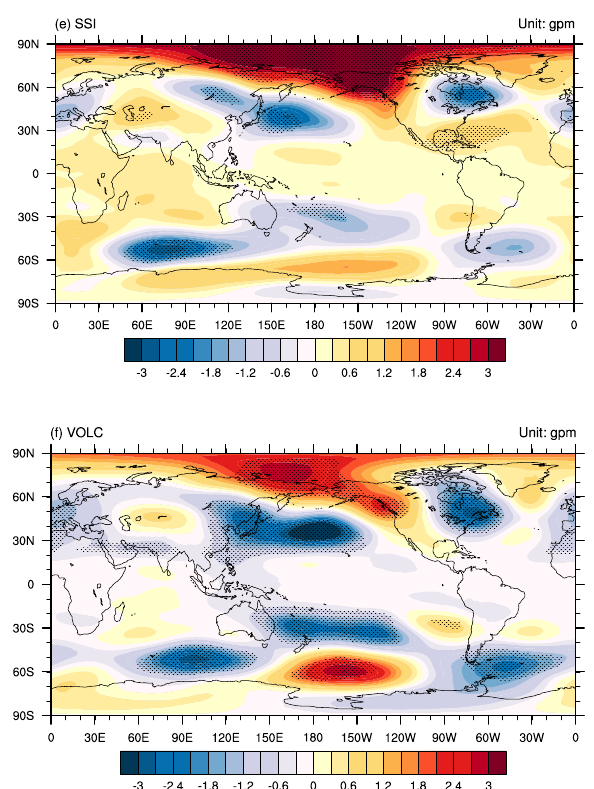
Figure 6. Simulated ensemble-averaged annual geopotential height anomalies at 500 hPa (unit: gpm) during the megadrought years from the long-term means of the control (CTRL) run ( a ), all-forcing (ALL) runs ( b ), greenhouse gas (GHG) runs ( c ), land use and land cover (LULC) runs ( d ), spectral solar irradiance (SSI) runs ( e ), and volcanic eruption (VOLC) runs ( f ). Stippling indicates differences significant at the p = 0.05 level based on a t -test. For clarity, the ranges of color bars are different.